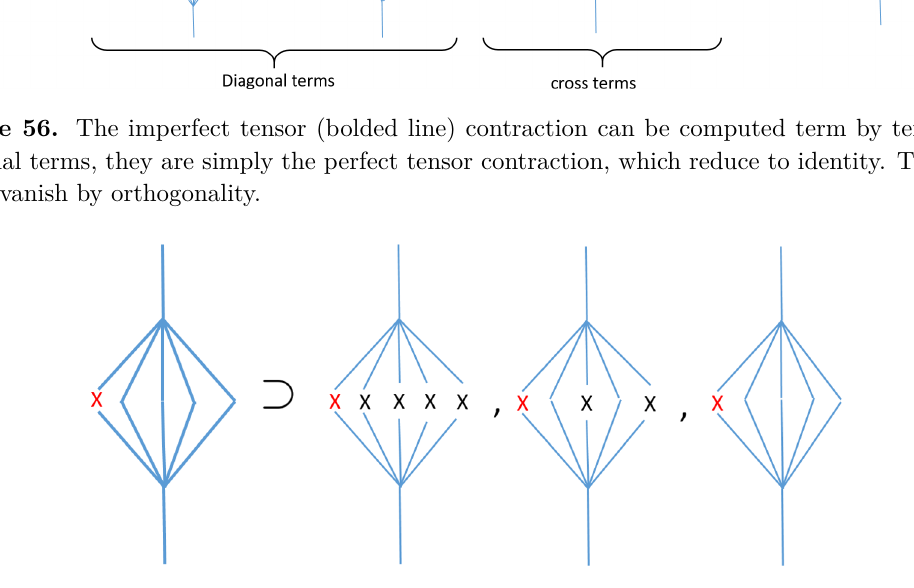
Figure 57. A contraction of the imperfect tensor with a single X insertion give rise to 3 types of terms. The inserted X operator is marked red, and the rest of the X operators are from the definition. Only the first one contributes by applying a stabilizer and pushing the weight 5 X operator to a weight 1 operator to the top or bottom. The rest vanish by